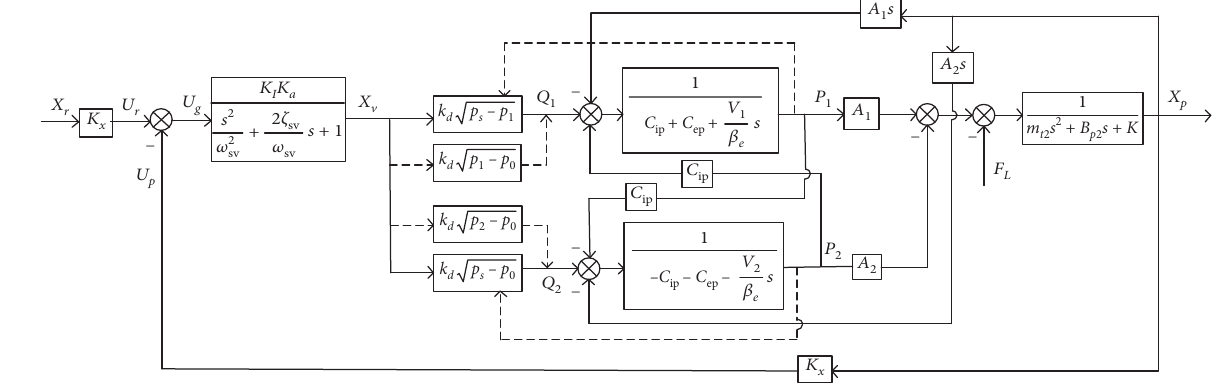
Figure 2: Transfer block diagram for the HDU position closed-loop control system. Table 1: Parameters vary with the motion direction of the